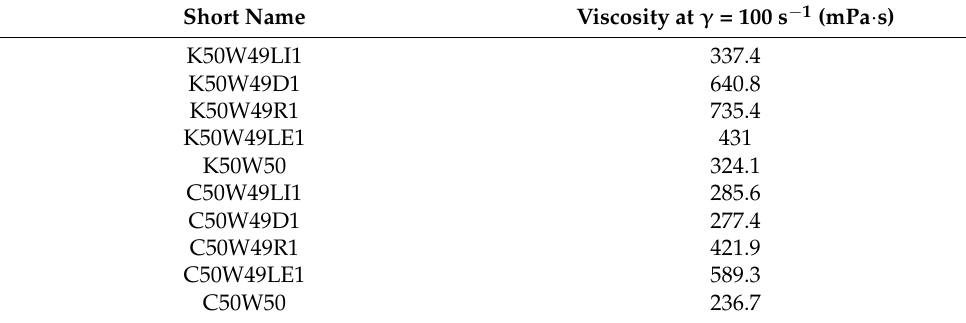
Table 4. Viscosity measurements of slurry fuels used in the